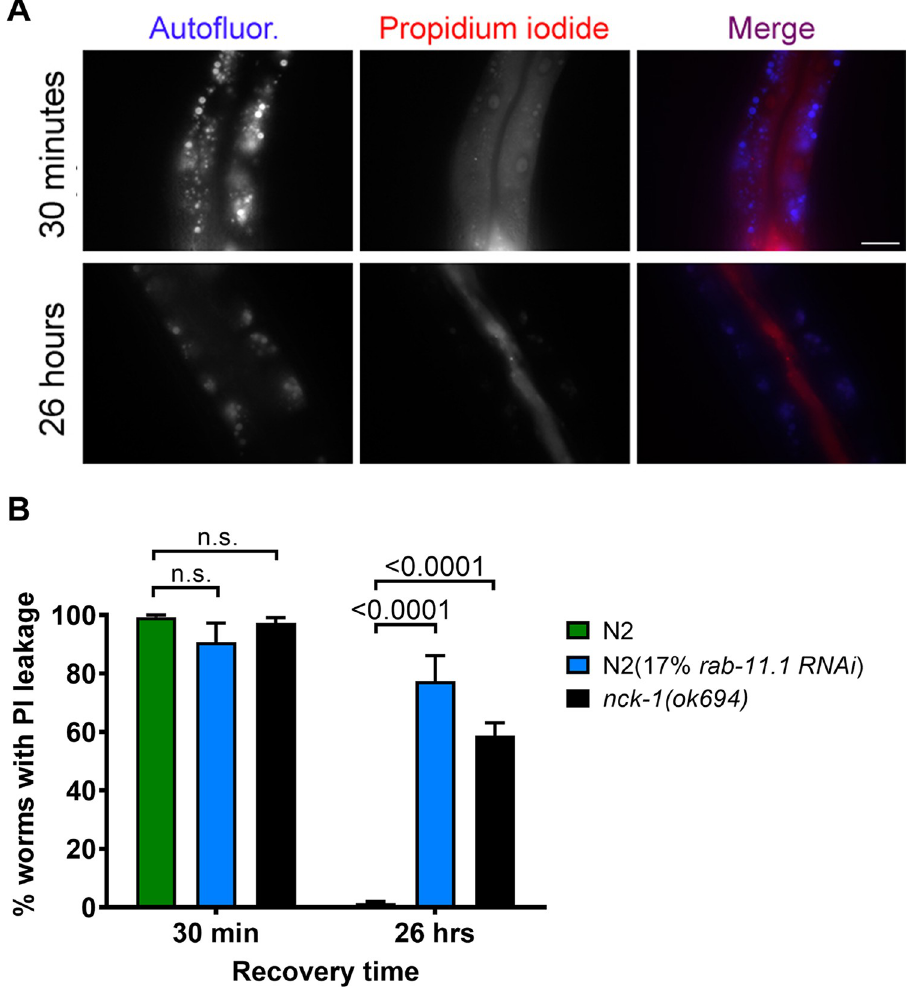
iodide within 30 minutes or allowed to recover for 26 hours and then fed propidium iodide. Dye-loaded worms were imaged on slides. Autofluorescent gut granules serve as a surrogate marker indicating the position of the intestinal epithelial cells. Scale bar = 25um. (B) Quantitation of the same type of experiment as in (A) except the strains used were nck-1(ok694) null mutants (grown on standard OP50 E . coli ) and N2 (grown on either OP50 or rab-11 . 1 RNAi E . coli as indicated). “PI leakage” = animals with dye found in intestinal cell cytoplasm. The data represent the mean and SEM of three independent experiments with 50